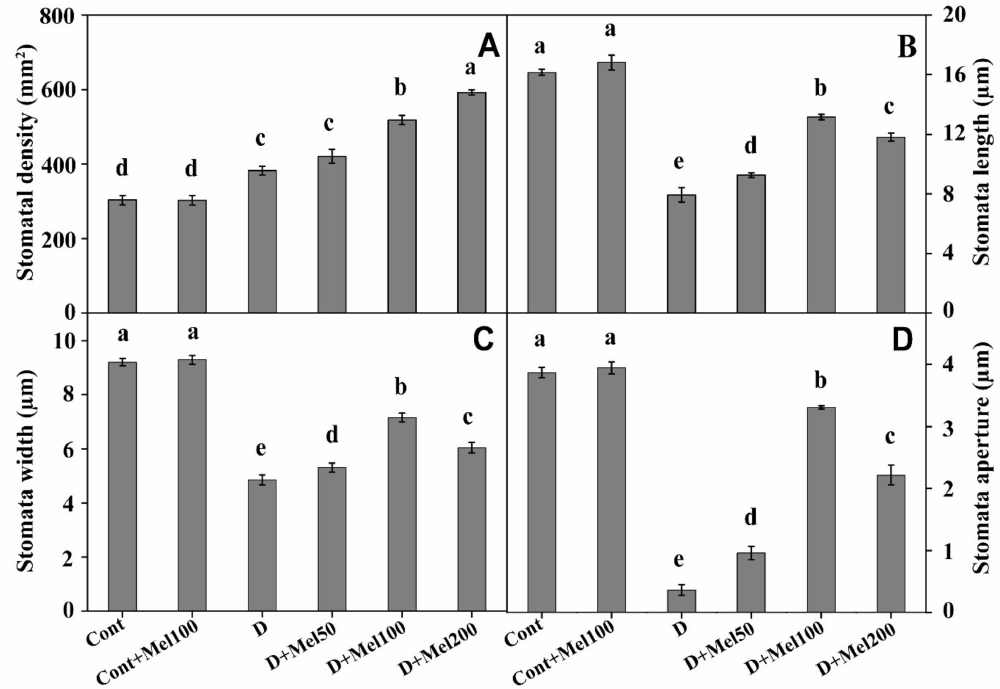
Figure 3. Impacts of melatonin supplementation on stomatal density ( A ), stomata length ( B ), stomata width ( C ) and stomata aperture ( D ) of Tartary buckwheat plants under drought stress. Here, Cont: Control, 80% field capacity (FC); D: Drought, 20% FC; Mel50: 50 µ M melatonin; Mel100: 100 µ M melatonin, and Mel200: 200 µ M melatonin. Values of all data are represented as mean ± standard error with three replications. Means values indicated with di ff erent letters refer to statistically significant di ff erences at p ≤ 0.05, according to Duncan’s multiple range